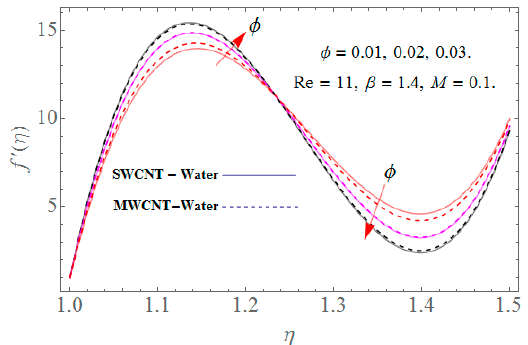
Figure 7. The impact of the nanoparticle volume fraction versus the velocity field.